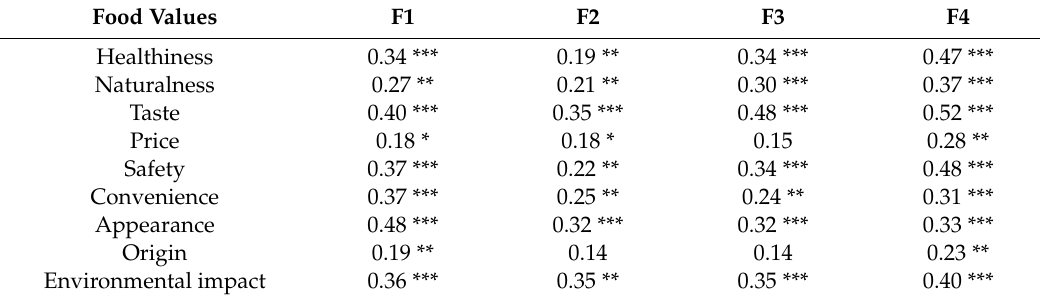
Table 7. Pairwise correlation index values for “non-informed”